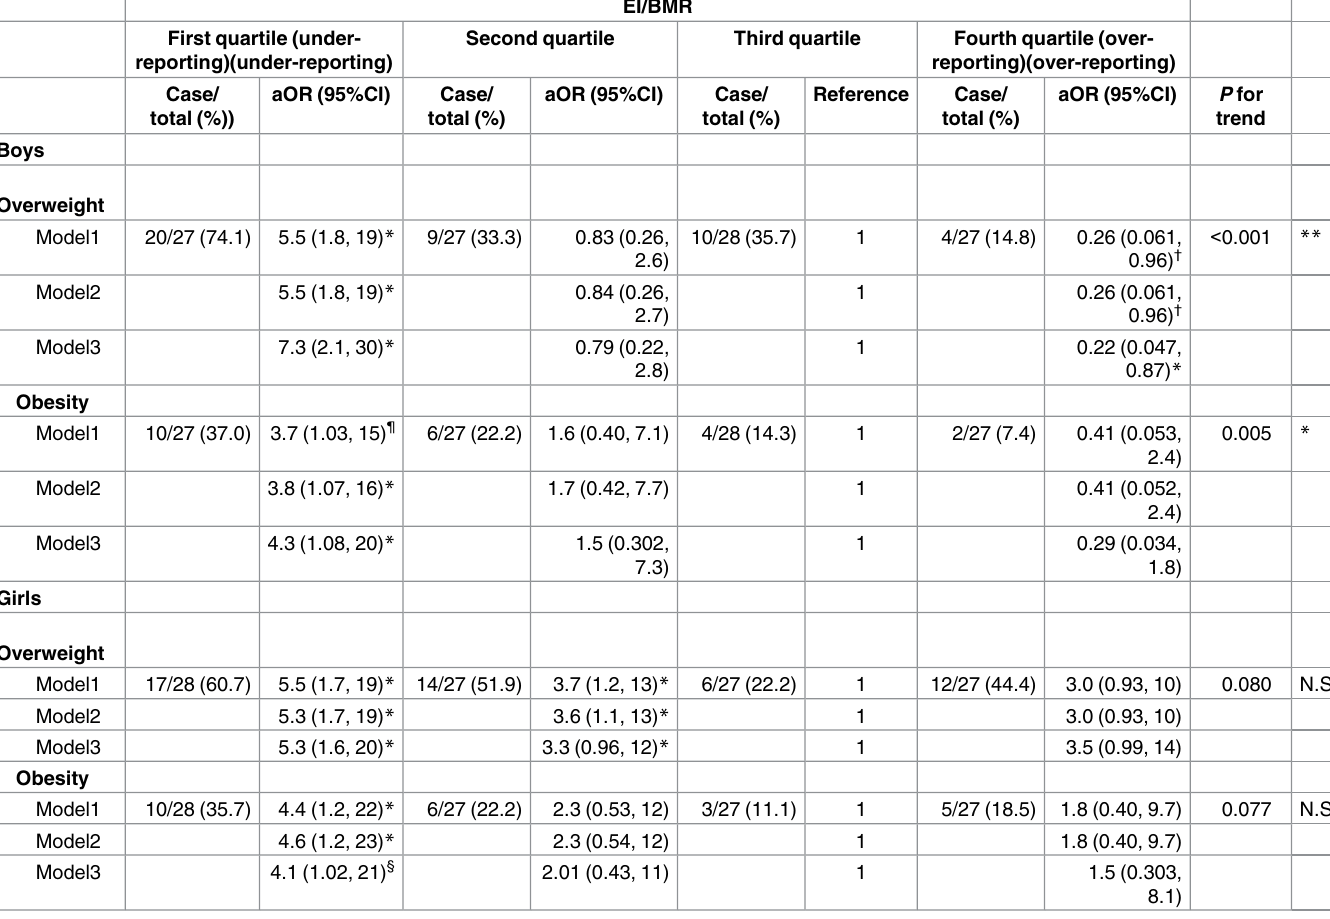
Table 4. Adjusted Odds Ratio of Overweight and Obesity in the EI/BMR Quartiles as Compared to the Third Quartile by a Multiple Logistic Regres- sion Model. EI/BMR First quartile (under- Second quartile Third quartile Fourth quartile (over- reporting)(under-reporting) reporting)(over-reporting) aOR (95%CI) Case/ Reference Case/ aOR (95%CI) P for total (%) total (%)